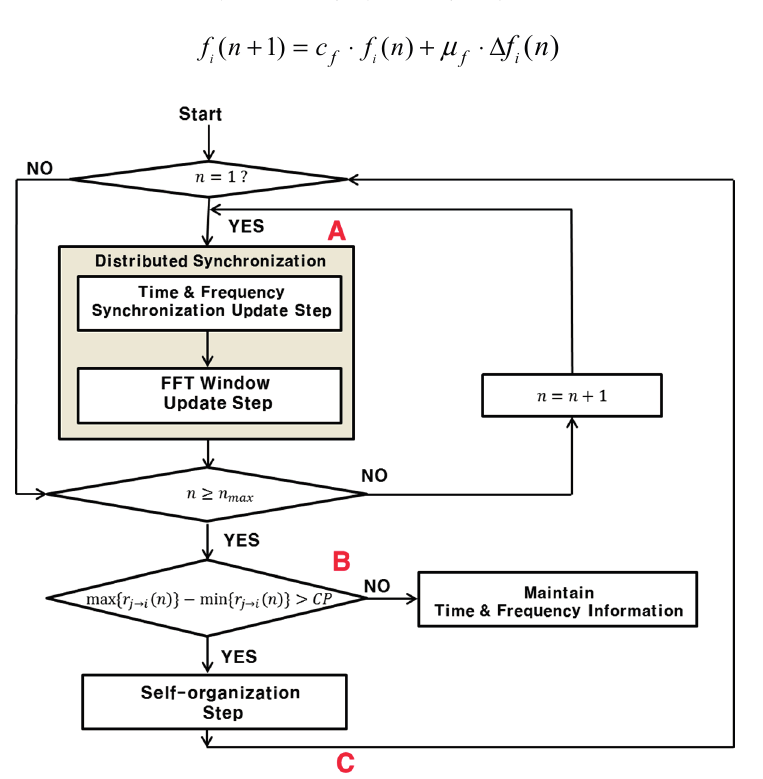
Figure 2. Flowchart of the proposed distributed synchronization